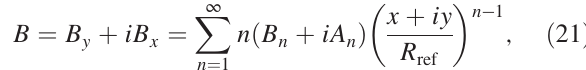
FIG. 6. Values of normalized multipole components for the model having 12 PMs, each having a 6 mm radius, for the cases where the position of each magnet randomly varies by (cid:3) 25 , (cid:3) 35 , and (cid:3) 50 μ m, respectively, from its ideal